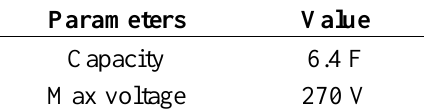
Table 2. Parameters of UC.